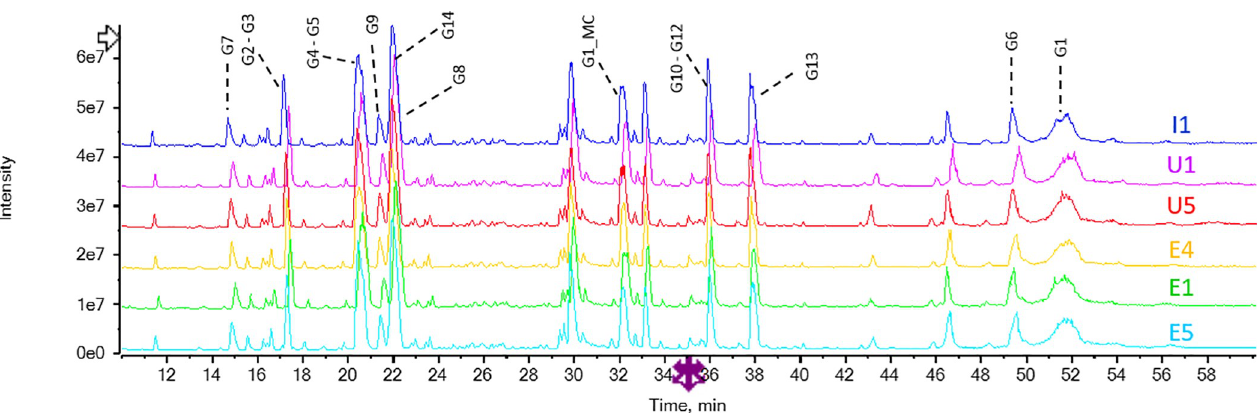
PLOS ONE | https://doi.org/10.1371/journal.pone.0212622 March 13,